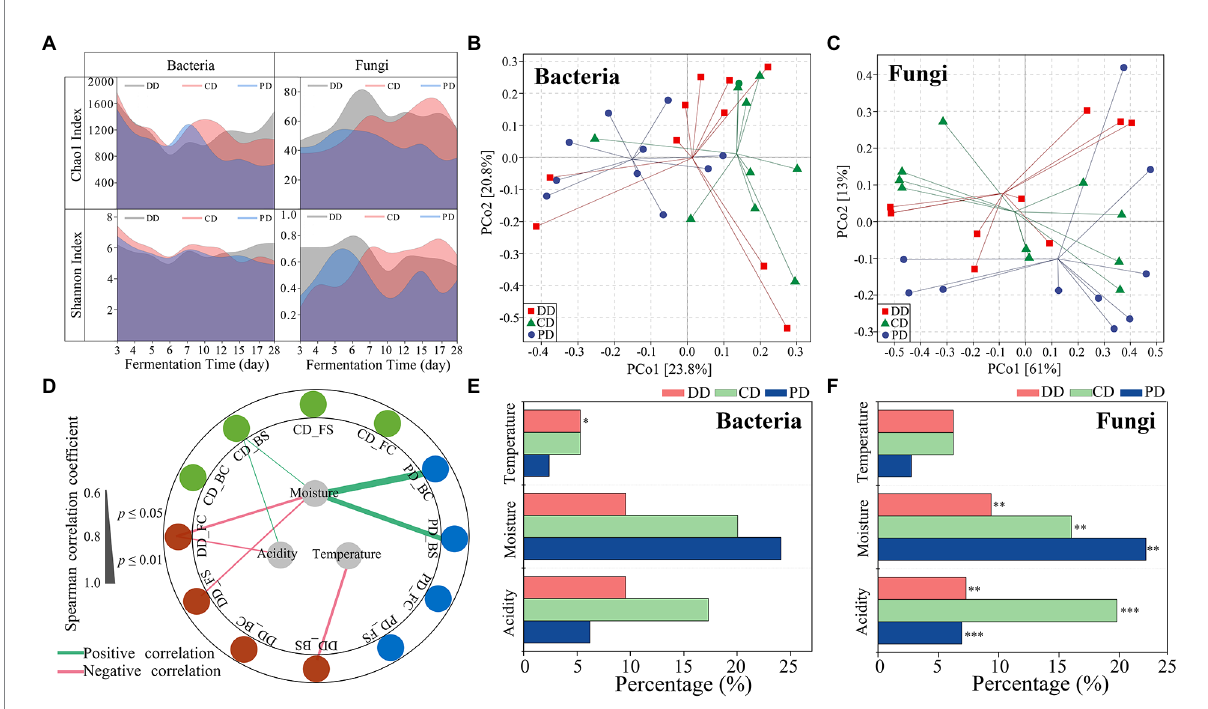
FIGURE 3 Microbial diversity and succession during the process. (A) Chao1 and Shannon indexes values for bacterial and fungal communities. (B,C) Group division according to principal coordinates analysis based on the Bray–Curtis dissimilarity matrix of microbial communities. (D) Correlation network between the α -diversity and fermentation parameters during the process (| ρ | > 0.60, p < 0.05). Abbreviations connected with underscores such as DD_BC, DD_BS indicated the bacterial Chao1 and Shannon index of the DD sample. (E,F) Percentage of the community turnover associated with different ecological processes as calculated using ASVs (Spearman, | ρ | > 0.60, p < 0.05). The significant effects of fermentation parameters on community are determined by mantel tests ( *** p < 0.001, ** p < 0.01, * p <